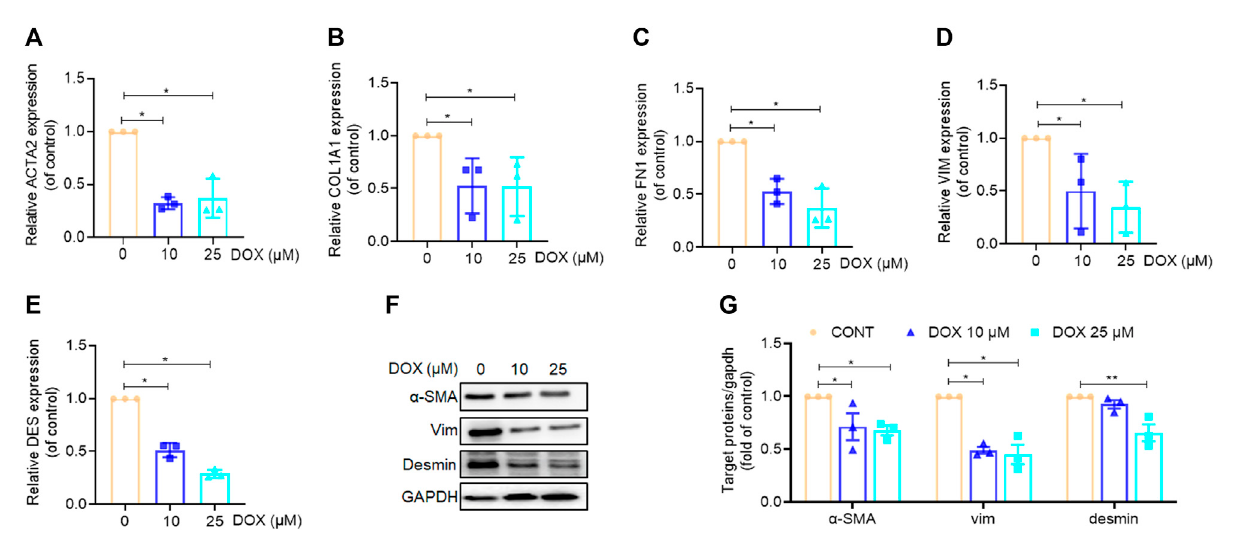
FIGURE 5 Effects of DOX inhibited HSC activation in vitro . LX-2 cells treated with DOX (10, 25 μ M) for 48 h (A – E) LX-2 cell ACTA2 ( α -SMA), COL1A1, FN1, VIM (Vimentin), DES (Desmin), mRNA expression ( n = 3). (F) The expression of LX-2 cell α -SMA, vimentin and desmin proteins was detected by Western blot, and GAPDH was used as a loading control. (G) The quantitative result of α -SMA, vimentin and desmin. The results represent three independent experiments. Data were expressed as means ± SEM. * p < 0.05; ** p <